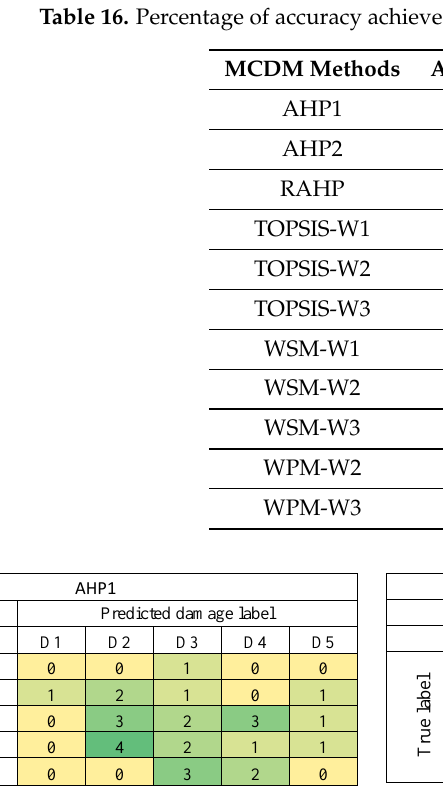
Figure 6. Confusion matrices for Analytical Hierarchy Process (AHP).